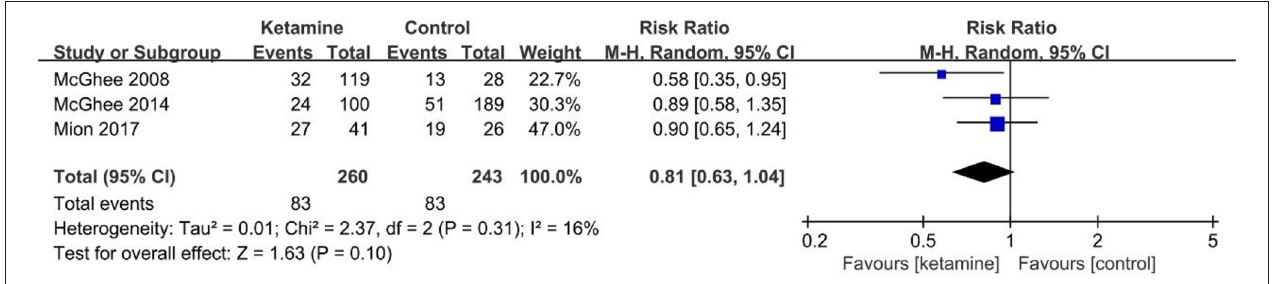
FIGURE 3 | Forest plot of the prevalence of PTSD in battlefield analgesia by ketamine. M–H,